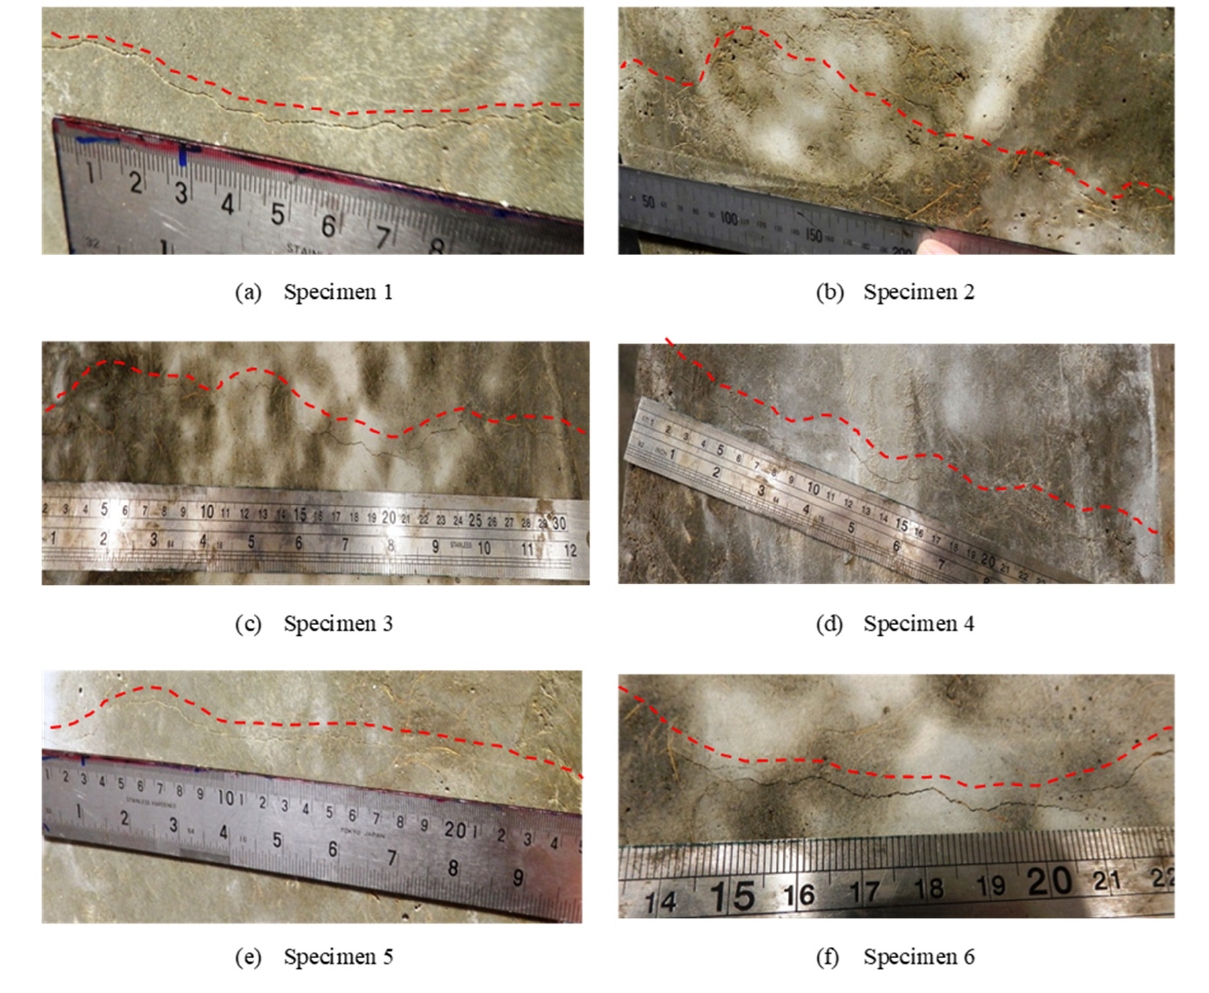
Figure 2. Crack damage of CFRC slabs under impact load.